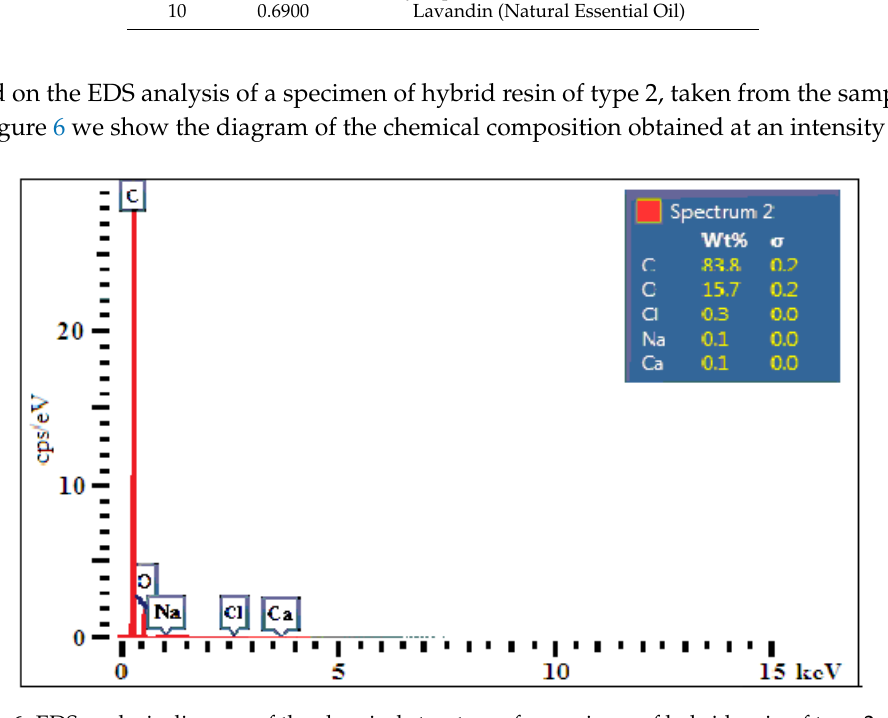
Figure 6. EDS analysis diagram of the chemical structure of a specimen of hybrid resin of type 2, taken from sample 2.x., obtained at an intensity of 15 keV.